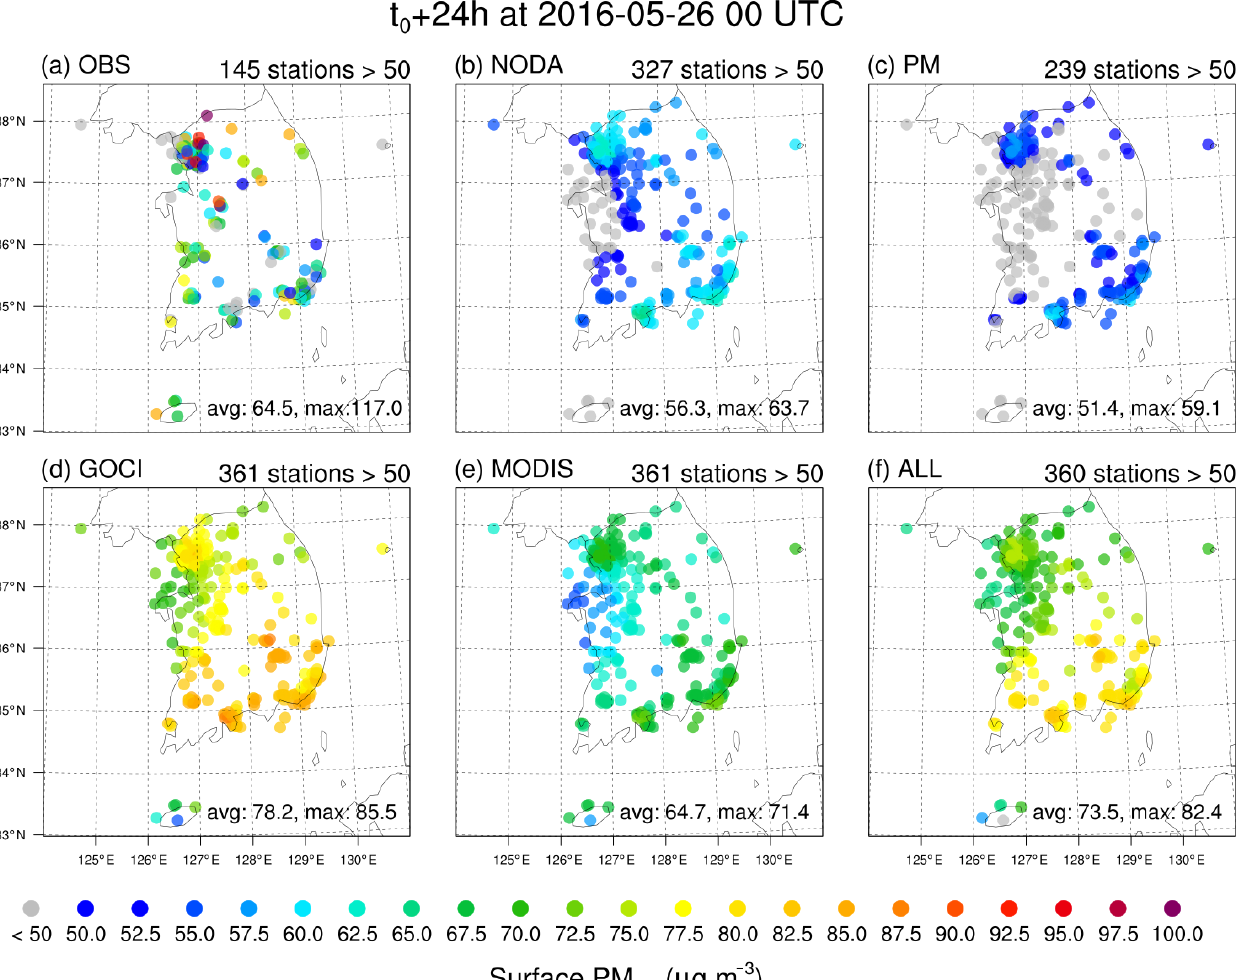
Figure 16. Horizontal distribution of 24h forecast in 9km simulations of PM 2 . 5 at the lowest level in each experiment compared to (a) ob- servations from 361 stations in South Korea valid at 00:00UTC on 26 May